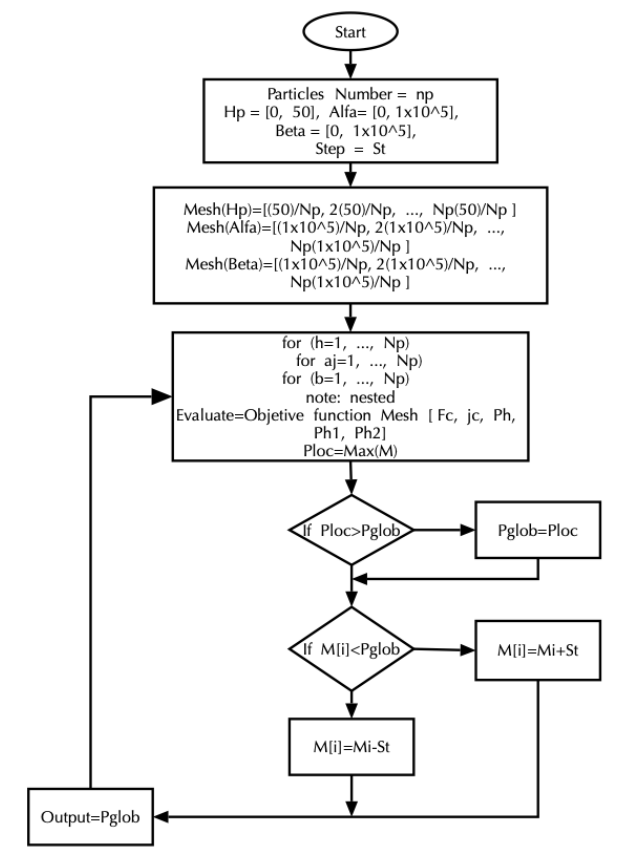
Figure 4. Proposed method based on pattern search to problem